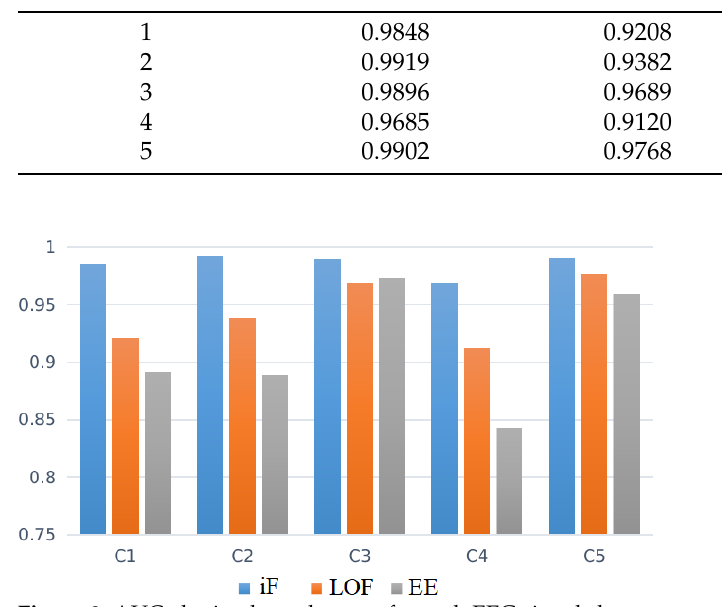
Figure 8. AUC obtained per detector for each EEG signal class.